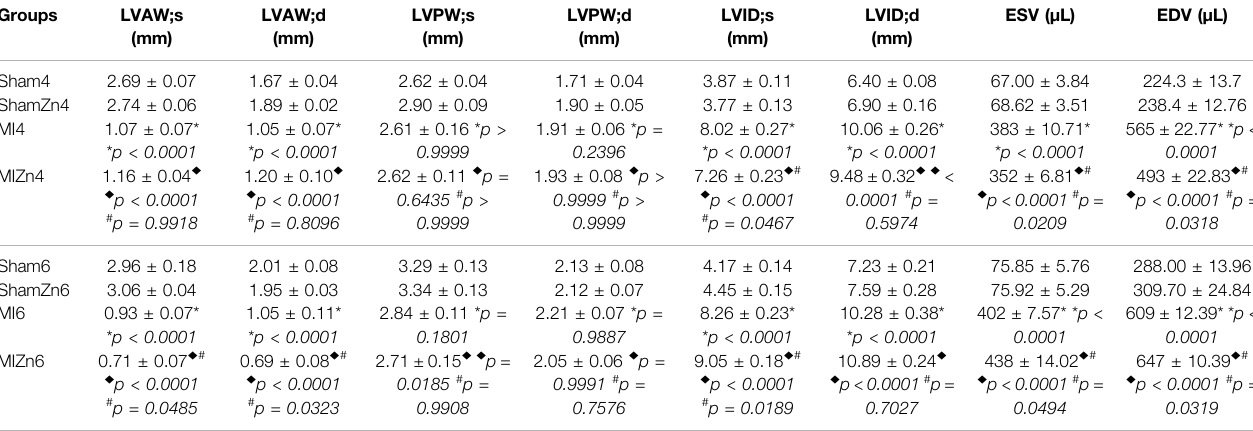
TABLE 1 | Morphometric parameters in the LV of eight groups at systole and diastole.